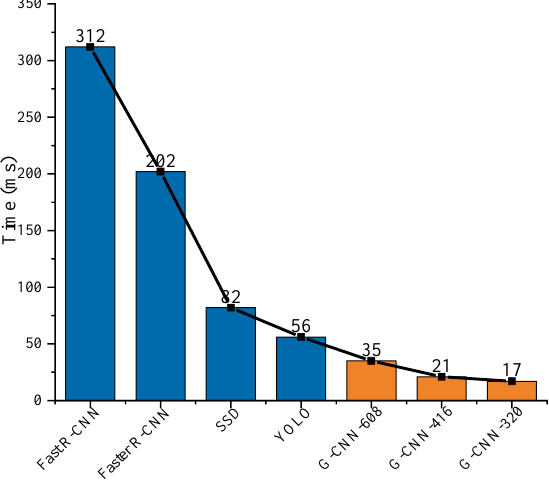
Figure 22. The ship detection time of different approaches.